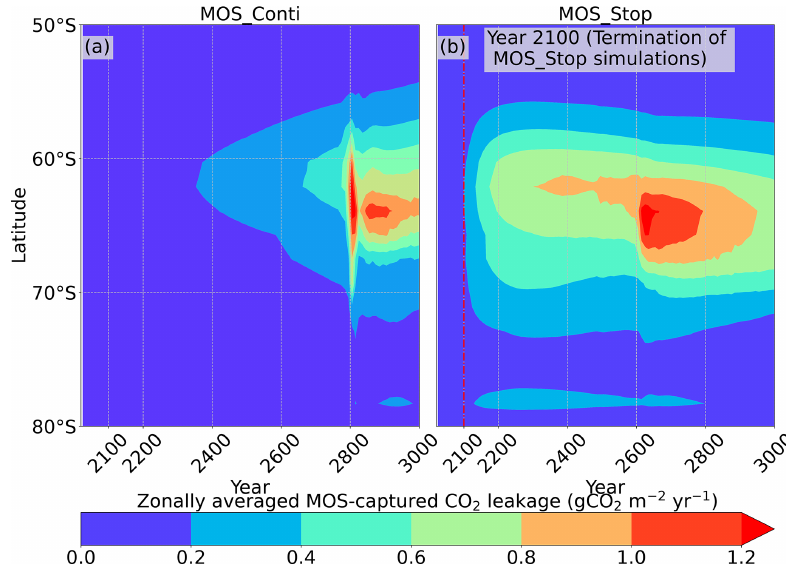
Figure 12. Zonally averaged MOS-captured carbon outgassing in the simulation ( a ) MOS_Conti and ( b ) MOS_Stop. When conveyed back to the surface, the DIC from MOS remineralization participates in the air–sea exchange (Sect. 2.2.5). MOS-C outgassing starts in year 2100 when MOS is terminated ( a ) or after year 2300 when MOS is continuously deployed. The outgassing mainly happens in the Southern Ocean. The outgassing is strengthened around year 2800 when a Southern Ocean deep-convection event accelerates the upwelling of deep waters with high concentrations of remineralized DIC (Sect.